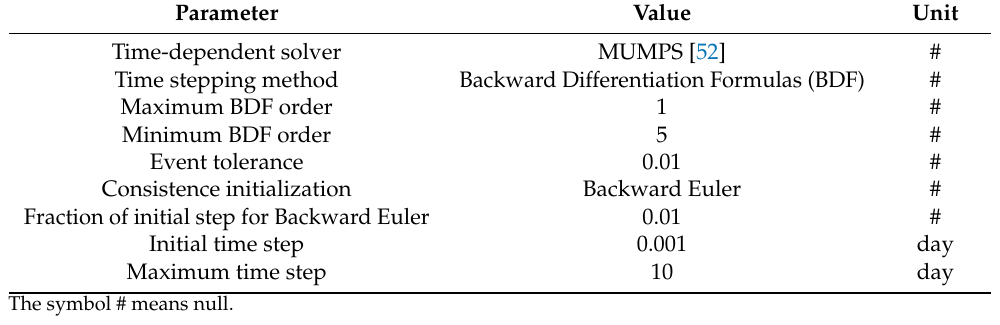
Table 3. Parameters for the numerical setting.